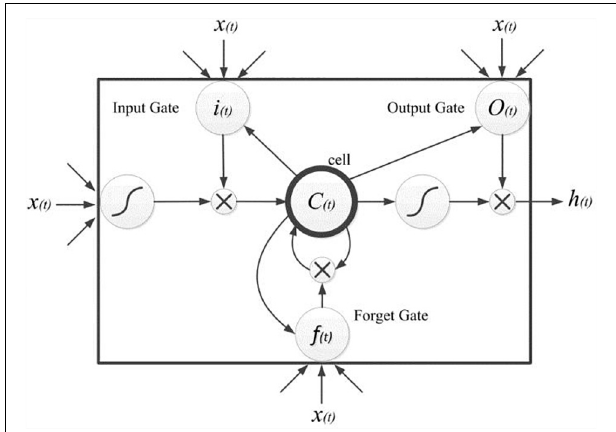
FIGURE 1 | LSTM unit structure (Graves,